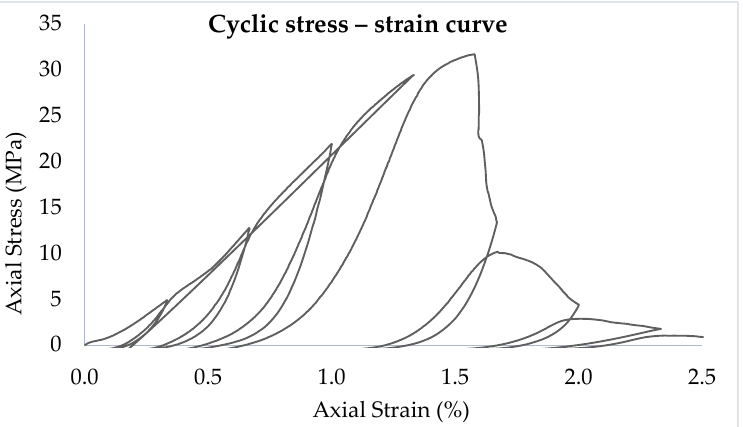
Figure 13. Axial stress versus axial strain curves of C-C1S2B2 concrete cylinder confined with MWCNT incorporated epoxy-based HSBFRP under cyclic axial load.